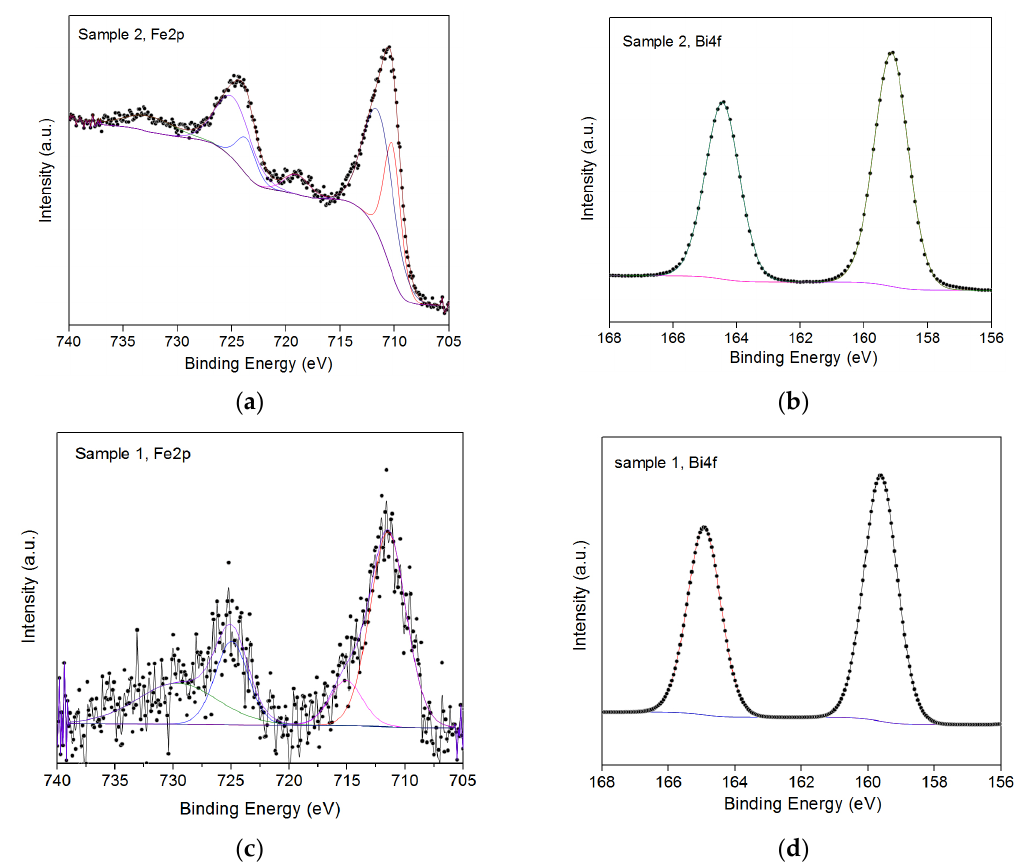
Figure 5. XPS from samples related to BFO film composition: ( a , c ) XPS from iron 2p electrons; ( b , d ) XPS from bismuth 4f